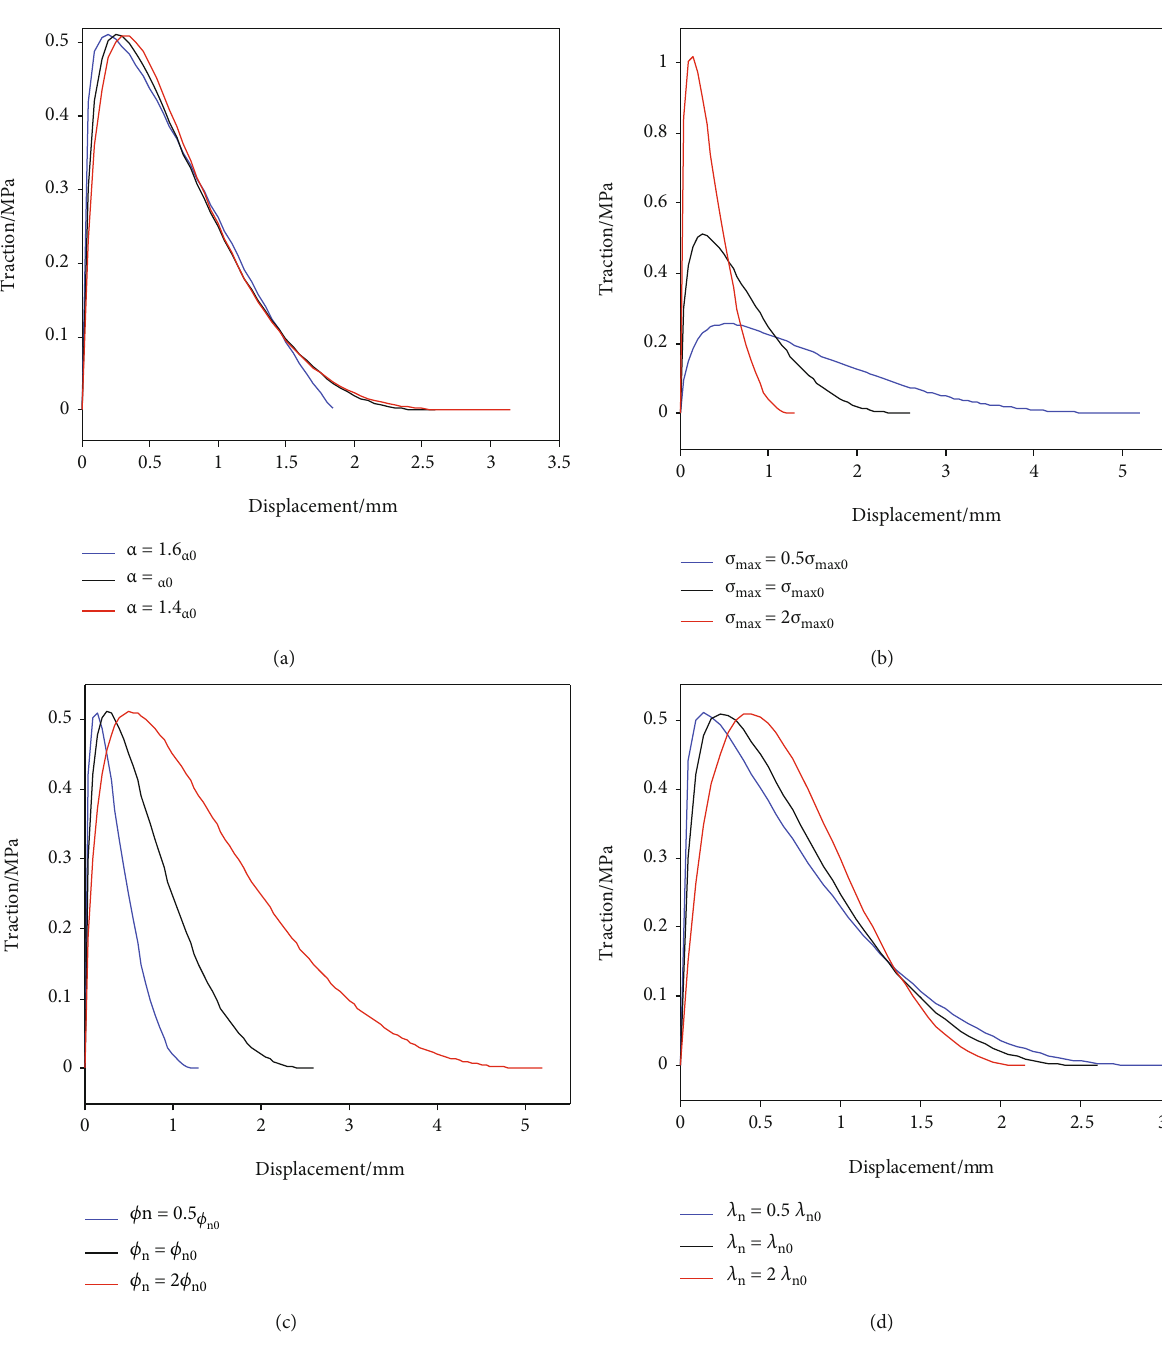
Figure 24: Normal traction in PPR CZM with respect to the increase of (a) α ; (b) σ